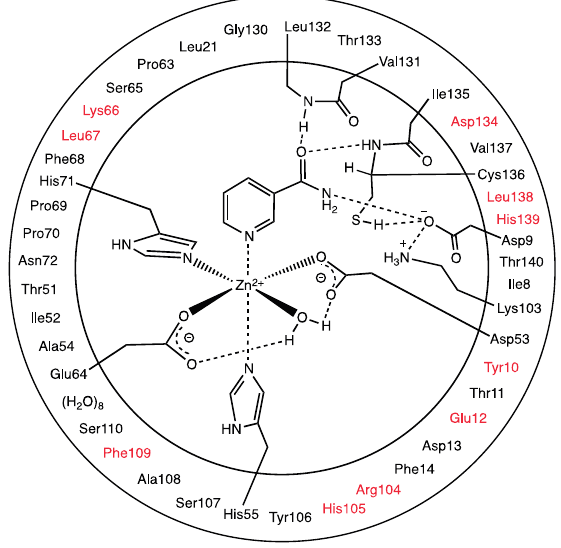
Figure 8. Schematic representation of the substrate-bound active site model used in the QM/MM calculations. The outer circle represents the MM-layer, while those in the inner circle represent the QM-layer. Residues in red were mutated to glycyl (see